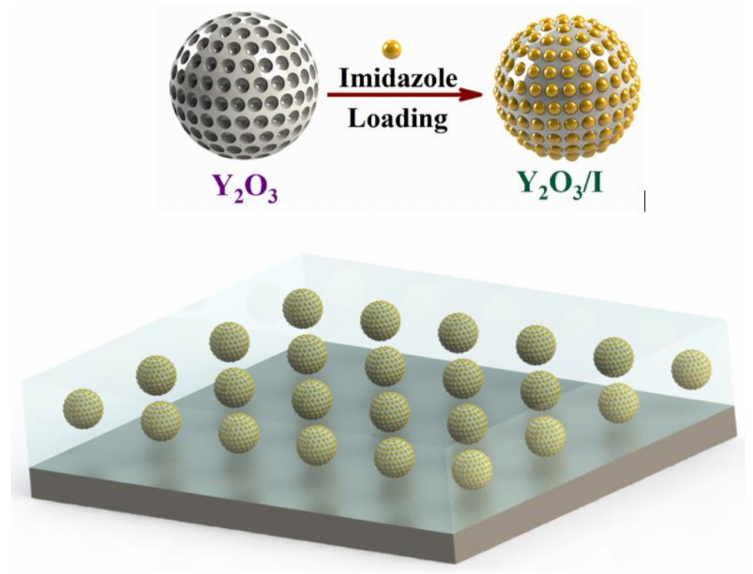
Figure 1. Schematic diagram showing the incorporation of Y 2 O 3 /IMD in the epoxy